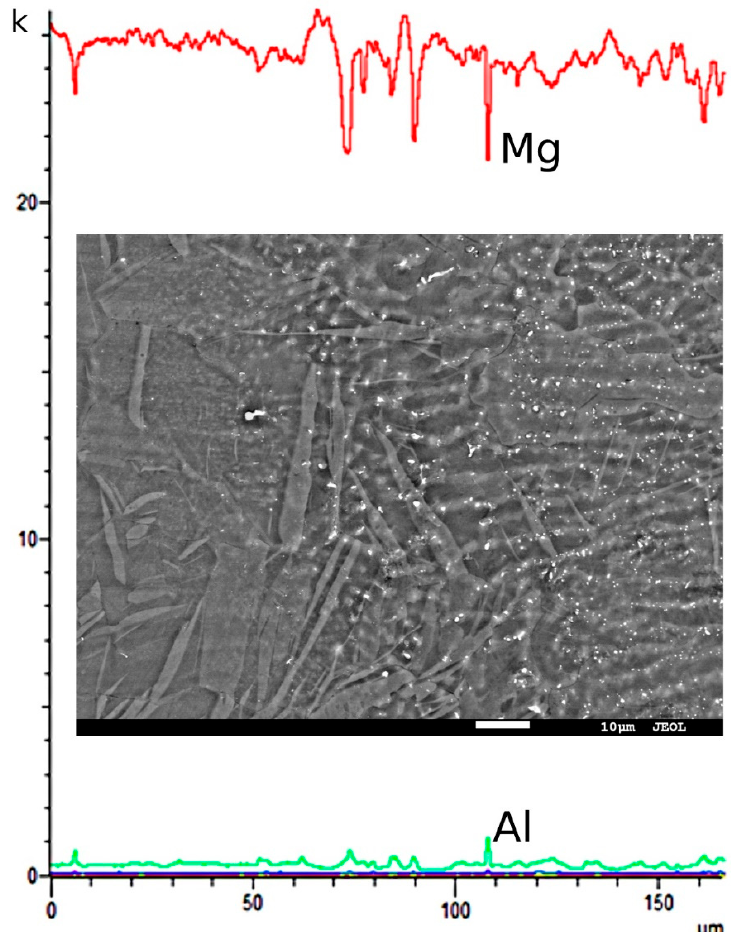
Metals 2023 , 13 , x FOR PEER REVIEW Figure 7. SEM image of the zone for EDS line analysis for weld no. 1. Figure 7. SEM image of the zone for EDS line analysis for weld no. 1.